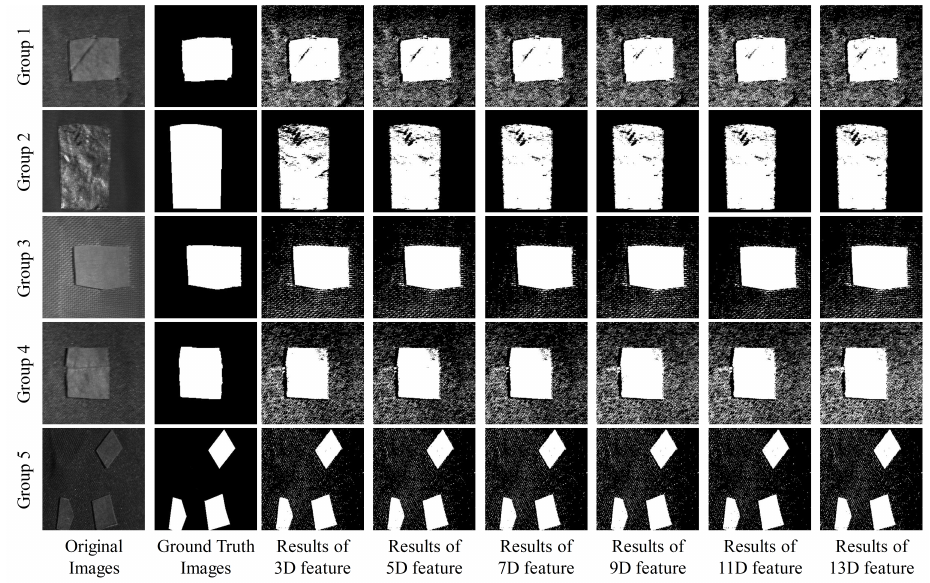
Figure 8. Diagram of the segmentation result images achieved by different dimensional